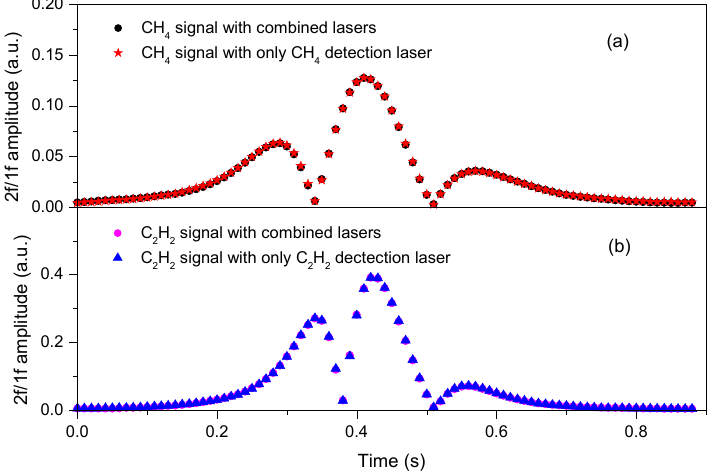
Figure 5. 2 f /1 f spectral profiles for a mixture of ( a ) 500-ppm CH 4 and ( b ) 500-ppm C 2 H 2 diluted in N 2 at 1 atm and room temperature, with DFB-LD1 modulated at 3 kHz and DFB-LD2 modulated at 4 kHz.